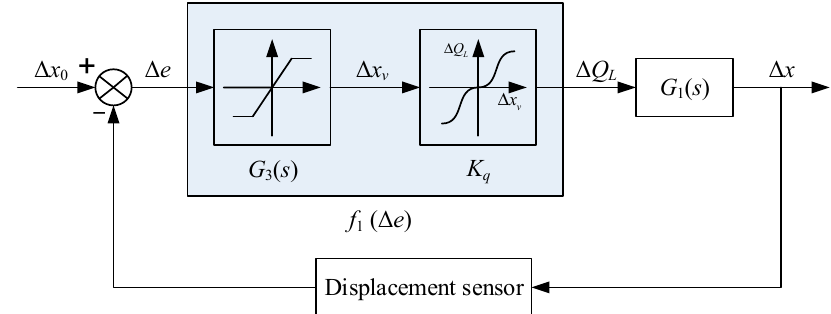
Figure 5. Transfer block diagram of the disturbance of the position closed-loop system.